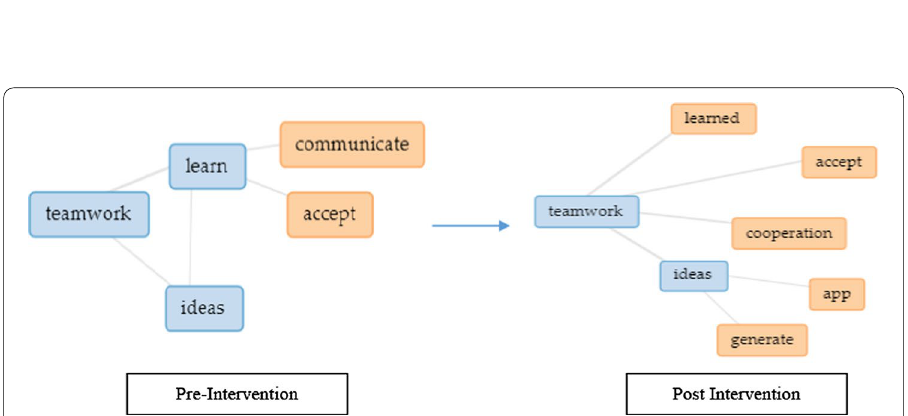
Fig. 7 Change in perception for the EC group based on aspects learn from